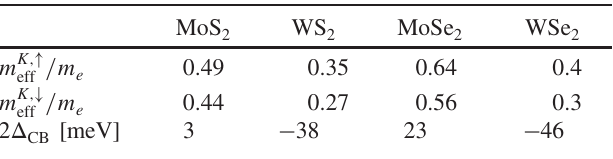
TABLE I. Effective masses and CB spin splittings appearing in the Hamiltonian [Eq. (1)] for different TMDCs. m electron mass.